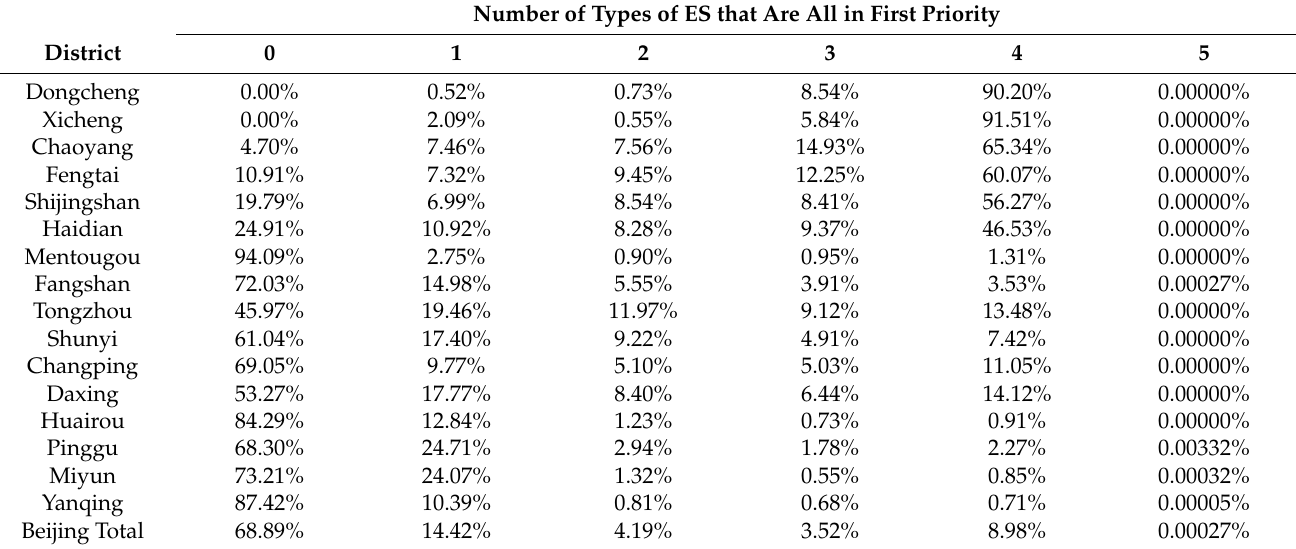
Table 3. Statistics on the overlapping of the first priority improvement area in each